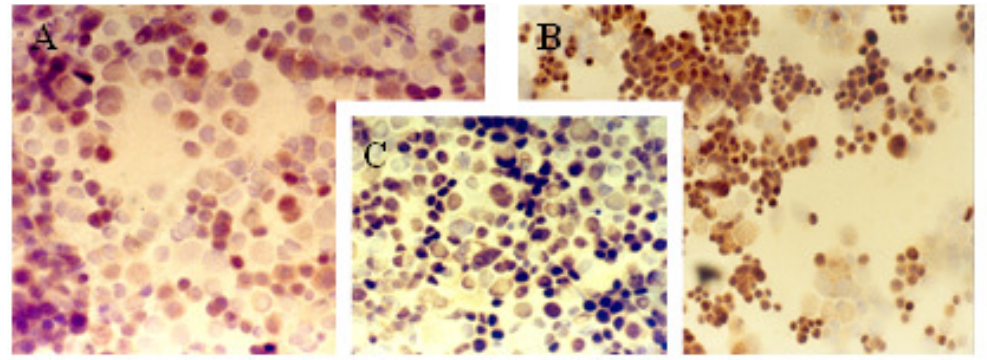
Figure 3. Immunocytochemical study with peroxidase staining of MCF-7 and MCF-7TG cells. Analysis of p53 antigen expression in: A, parental MCF-7cells; B and C, MCF-7TG cells induced with dexamethasone (1 mM) for 2 and 6 days, respectively, (A and C, X 400 magnification; B, X 200 magnification).